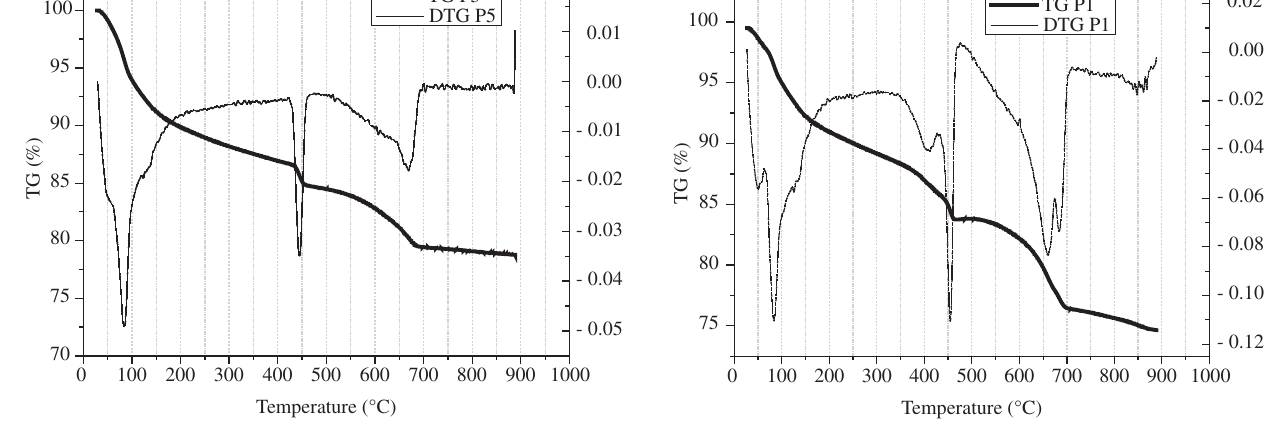
Figure 3. TG curve of the paste P1.